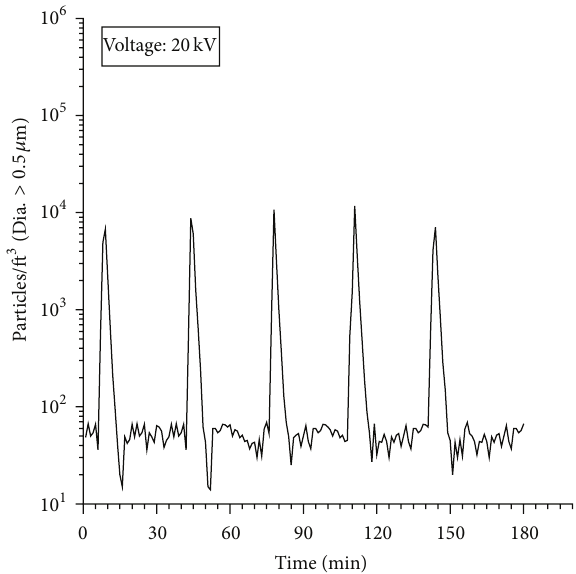
Figure 7: Plot of the SG-III slab amplifier aerosol concentrations during the last flashlamp